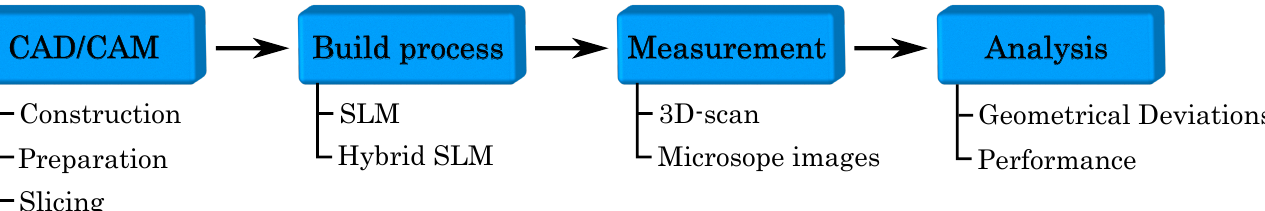
Figure 5. Methodical approach of the systematic creation of construction rules.